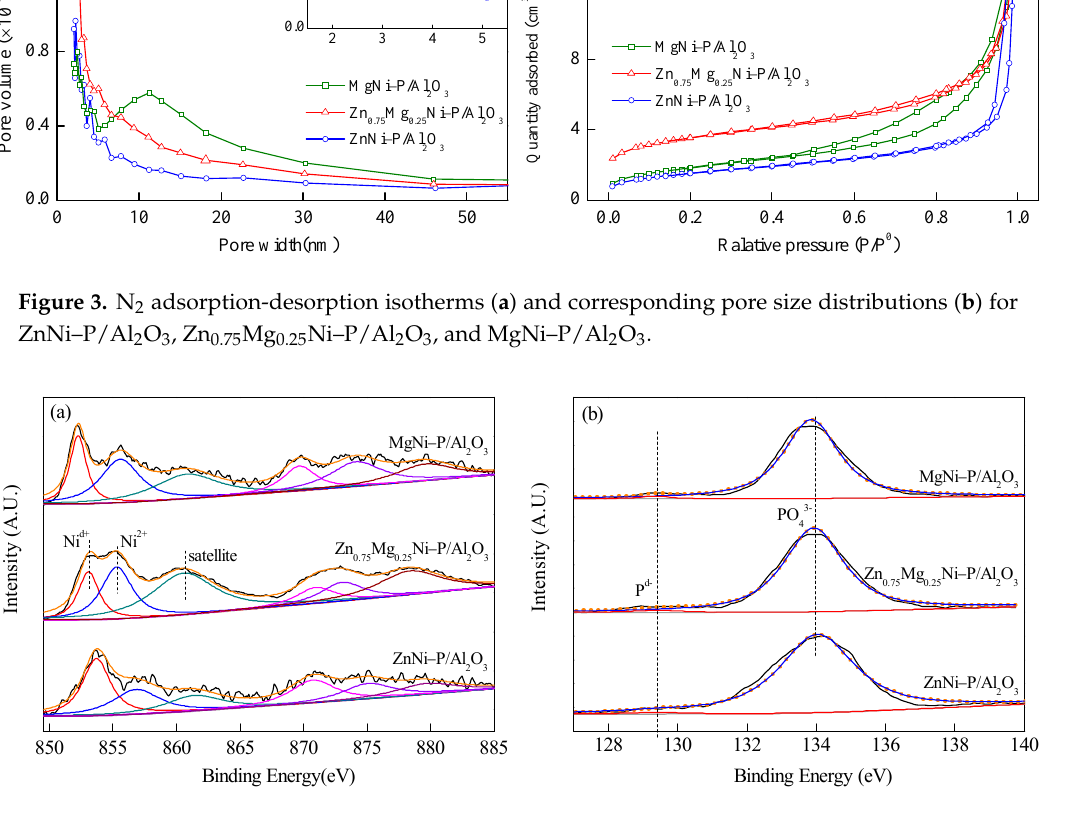
Table 3. Spectral parameters obtained by X-ray photoelectron spectroscopy (XPS) analysis.